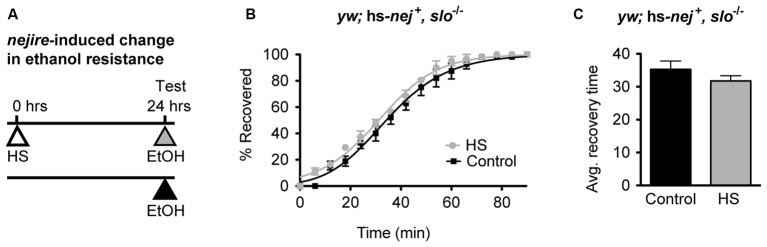
A mutation in slo blocks CBP-induced alcohol resistance. (A) Schematic depiction of the 2-day treatment protocol. A HS inducible transgenic construct in which the Hsp70 promoter drives expression of a nejire cDNA was used to drive expression of CBP in a null slo mutant background. Induction of the transgene was performed 24 h prior to sedation with ethanol. (B) Ethanol recovery curves of sloMI02233 (slo−/−) flies carrying the hs-nej + transgene. The black curve represents recovery from uninduced flies (Control), whereas the gray curve represents recovery from a CBP-induced flies (HS). (C) The average recovery time of control and heat-shocked induced flies (HS) is plotted. CBP induction does not affect recovery time from ethanol. Error bars represent SEM (Student’s t-test: not significant).